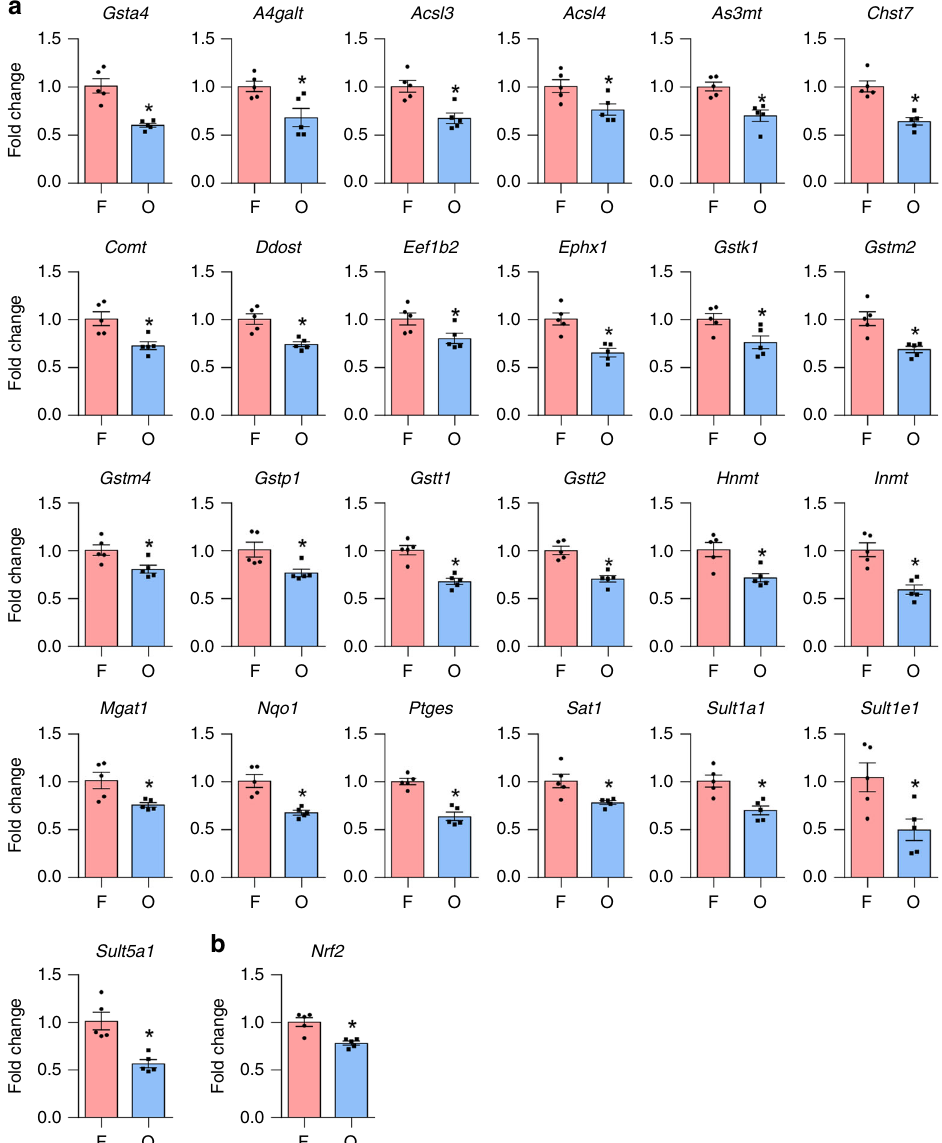
Fig. 7 Assessment of mRNA-expression levels of detoxi fi cation genes in the inner ears of CBA/CaJ mice. a mRNA expression levels of 25 genes involved in the enzymatic processes of Phase II detoxi fi cation were analyzed by PCR arrays in the inner ears from female and OVX CBA/CaJ mice. n = 5, * p < 0.05 vs. F (unpaired two-tailed Student t test). Error bars represent ± s.e.m. b mRNA expression levels of Nrf2 were measured by qRT-PCR in the inner ears from female and OVX CBA/CaJ mice. n = 5, * p < 0.05 vs. F (unpaired two-tailed Student t test). Error bars represent ± s.e.m. The relative mRNA levels were normalized to levels of B2m . F: female, O: ovariectomized female. Source data are provided as a Source Data fi